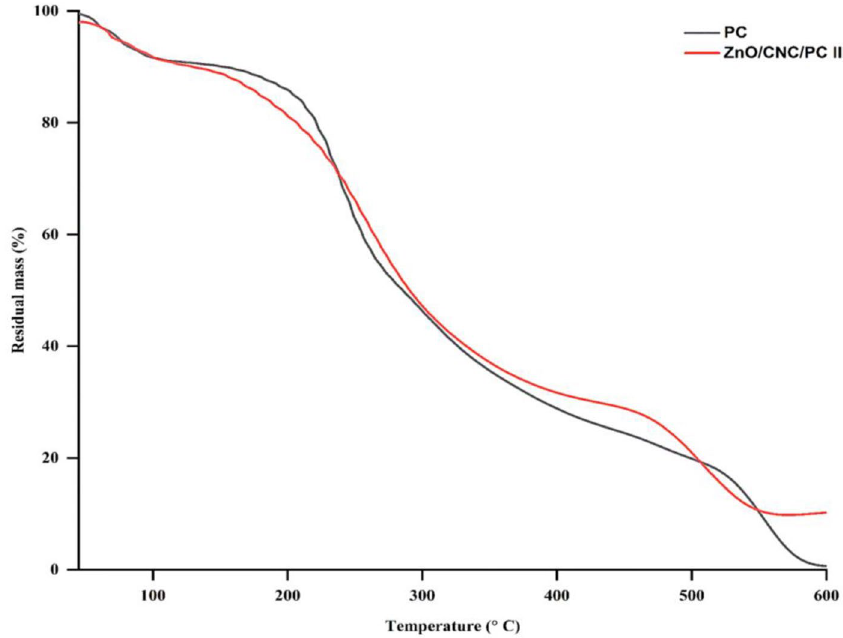
Figure 5. TGA thermograms of PC and ZnO/CNC/PC III